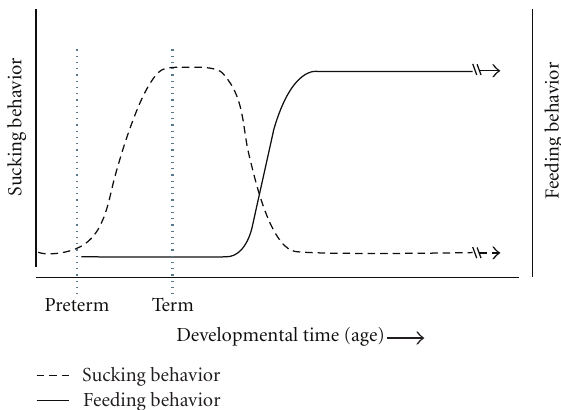
Figure 3: An idealized depiction of the coordinate development of suckling and feeding behavior which, together, comprise the devel- opment of oral ingestion. Note that the horizontal axis depicts an unspecified range of “developmental time” with vertical markers exemplifying a preterm birth and a term birth. The purpose of noting these events is to illustrate that the suckling system may not be functionally ready for the preterm infant, whereas it is prepared to be engaged at